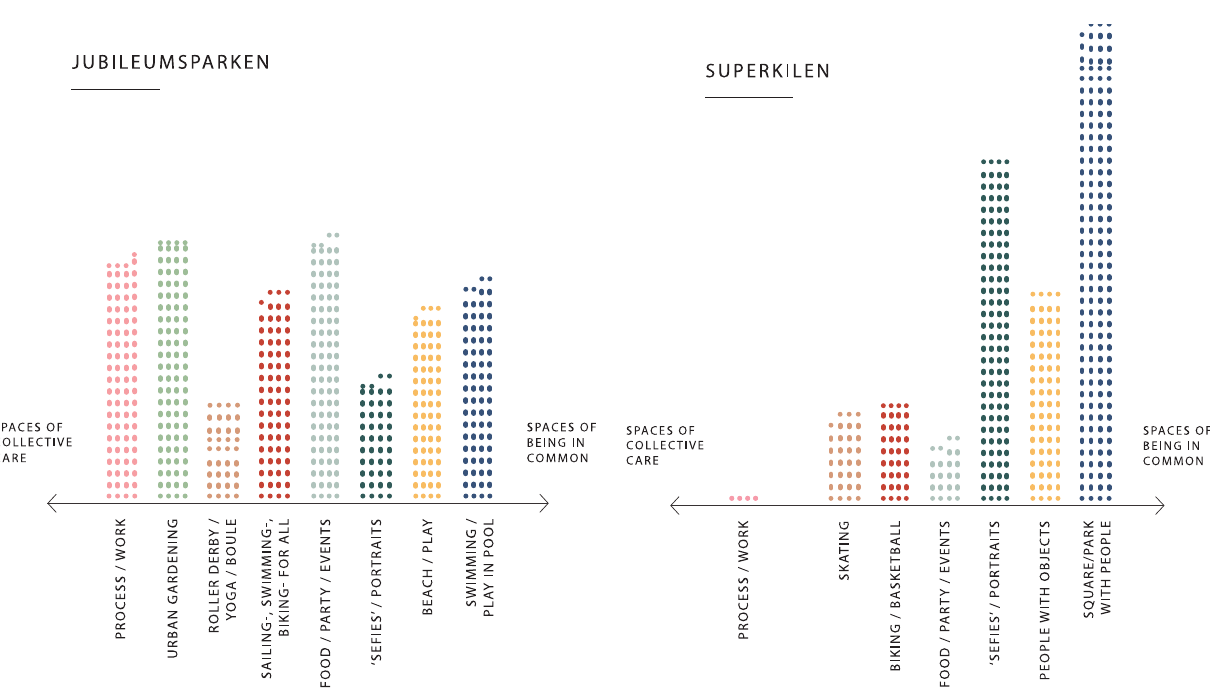
Figure 7. Instagram posts from Jubileumsparken and Superkilen categorised on a scale from spaces of collective care (ethics of care) to spaces of being-in-common (ethics of affect). Note: Each dot represents one Instagram post. Source: Ida